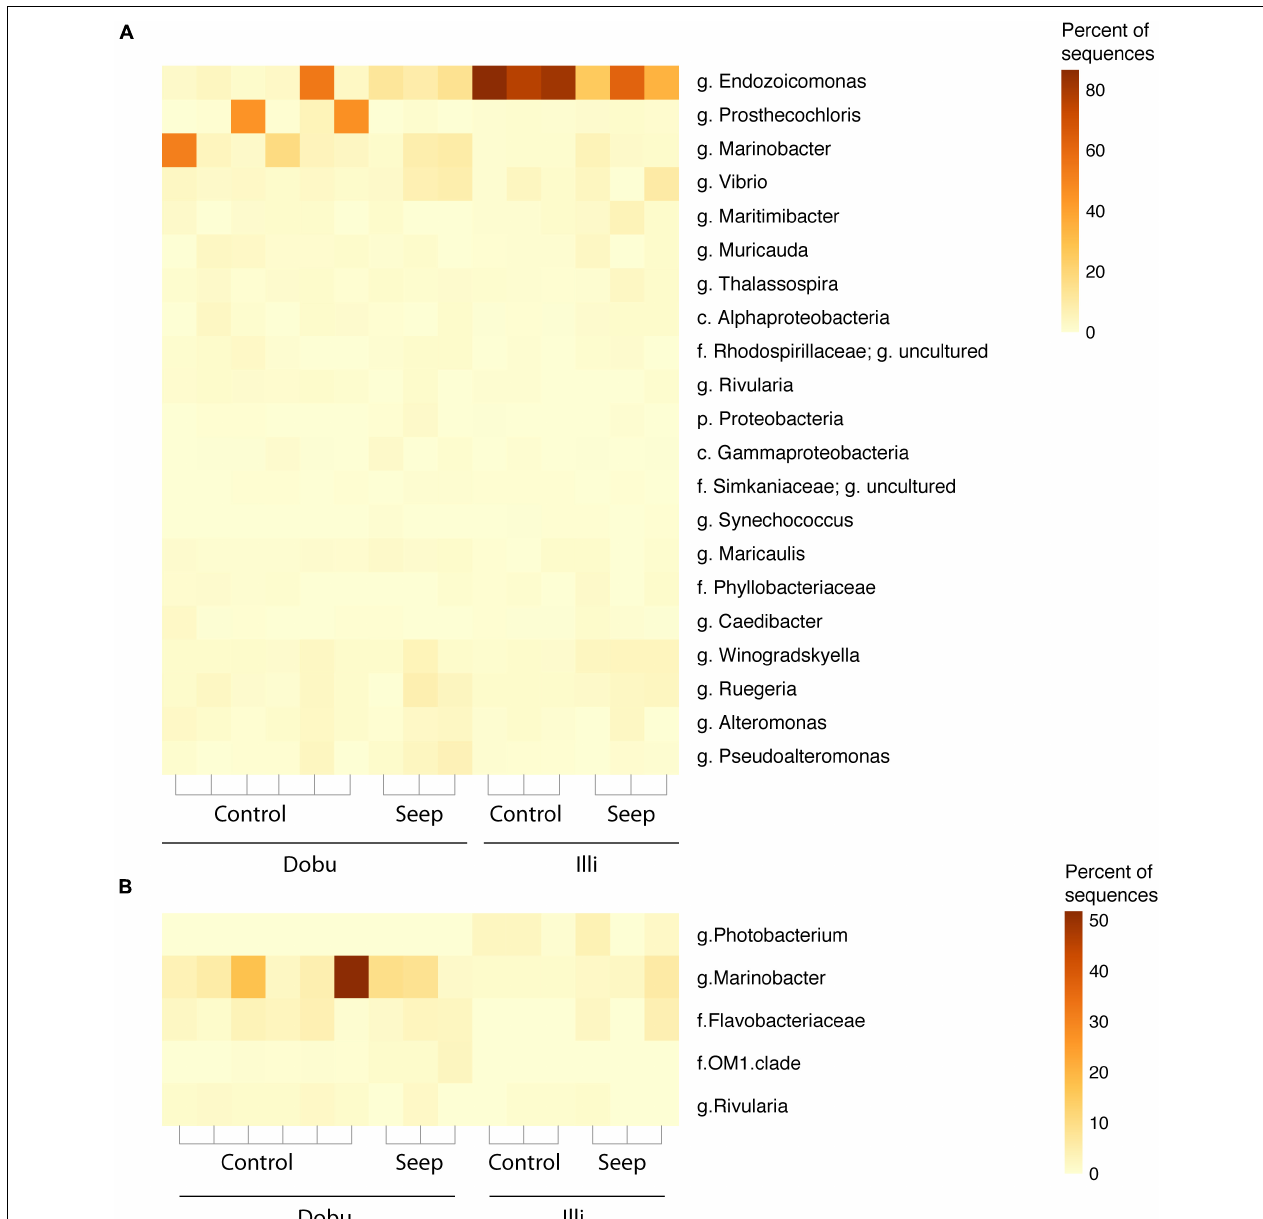
FIGURE 6 | (A) Relative proportion of core microbes (the 22 taxa found in 100% of samples). (B) Relative proportion of indicator taxa (taxa found to be significantly correlated ( p < 0.05) to each site). Taxa are identified to the lowest possible classification, where p. is phylum, c. is class, f. is family, and g. is genus.